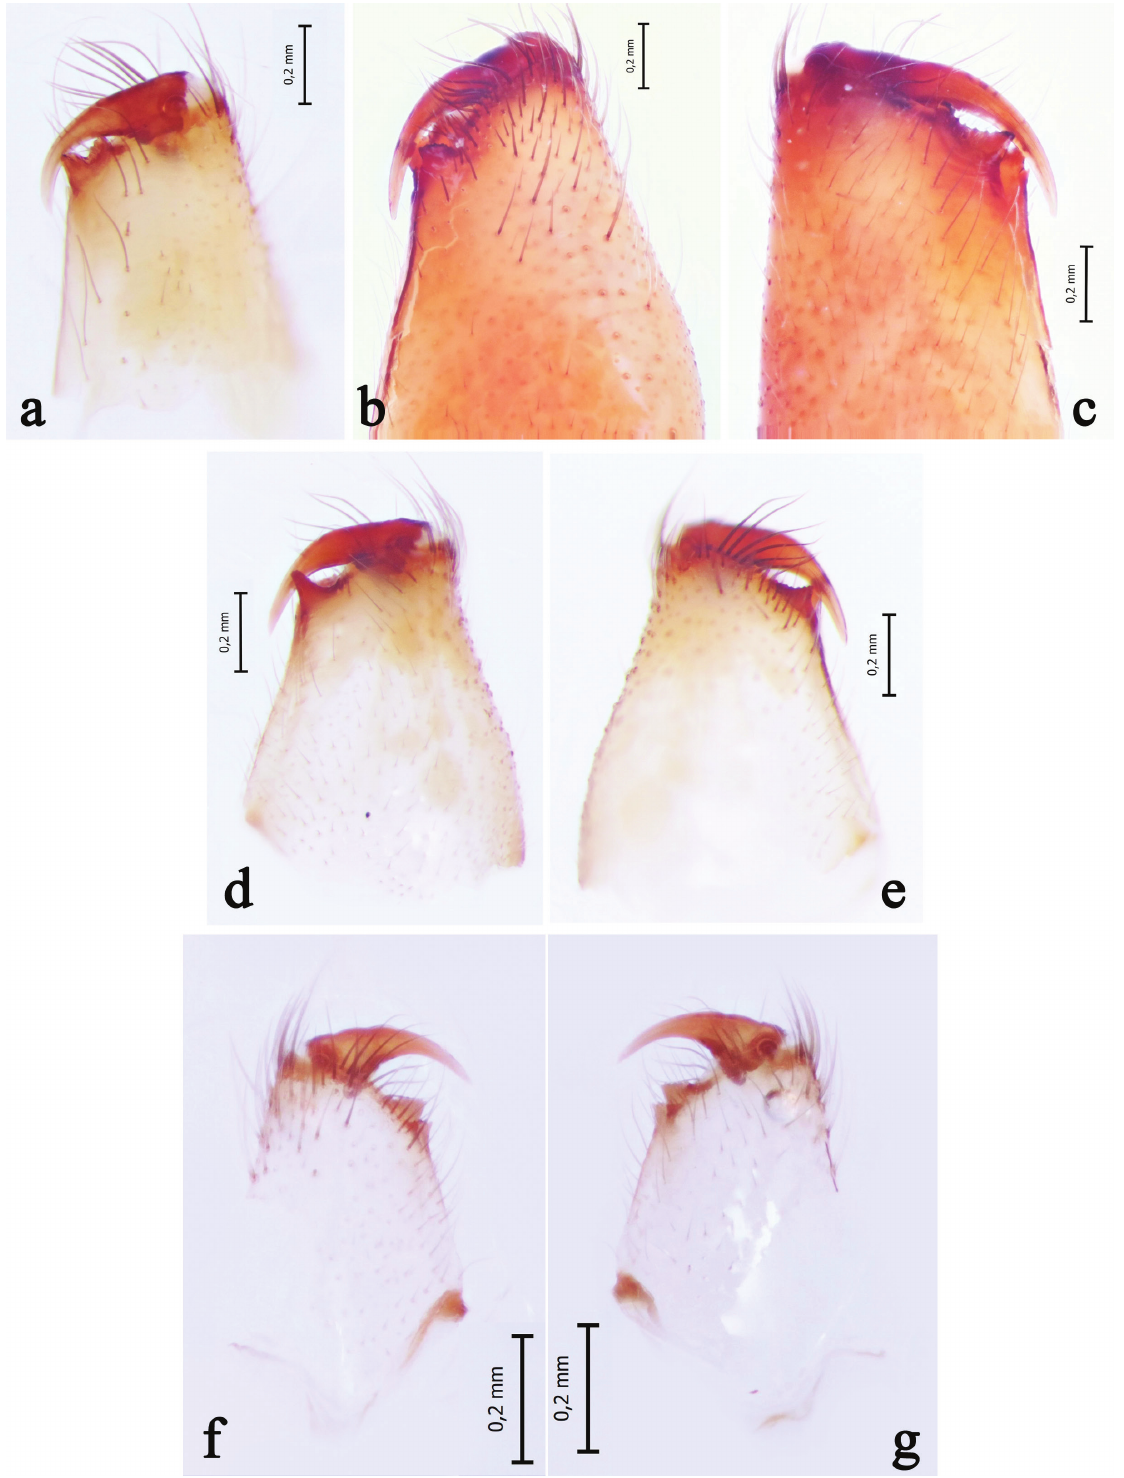
Figure 5. Chelicerae of Pterotricha spp.: a ) male P. arabica sp. n., retrolateral view; b, c ) P. esyunini sp. n., retro- and prolateral views; d, e ) P. nadolnyi sp. n., retro- and prolateral views; f, g ) P. stevensi sp. n., pro- and retrolateral